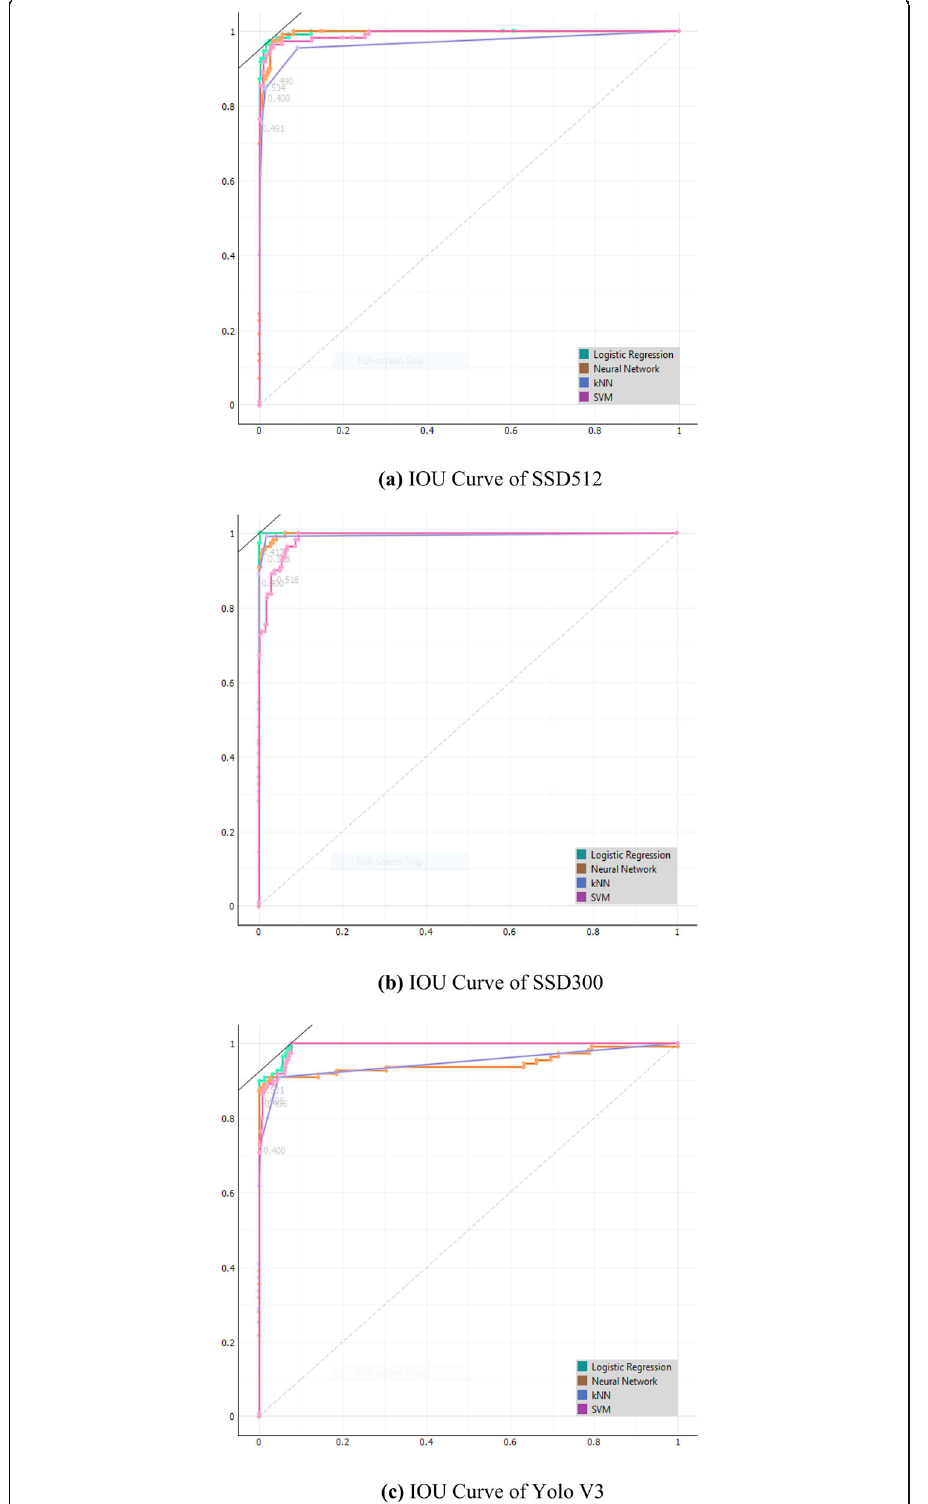
Fig. 8 a IOU Curve of SSD512. b IOU Curve of SSD300. c IOU Curve of Yolo V3. Our proposed approach gives us the highest accuracy of 96.7%. a – c Shows the different curves implemented on SSD312, SSD300, and